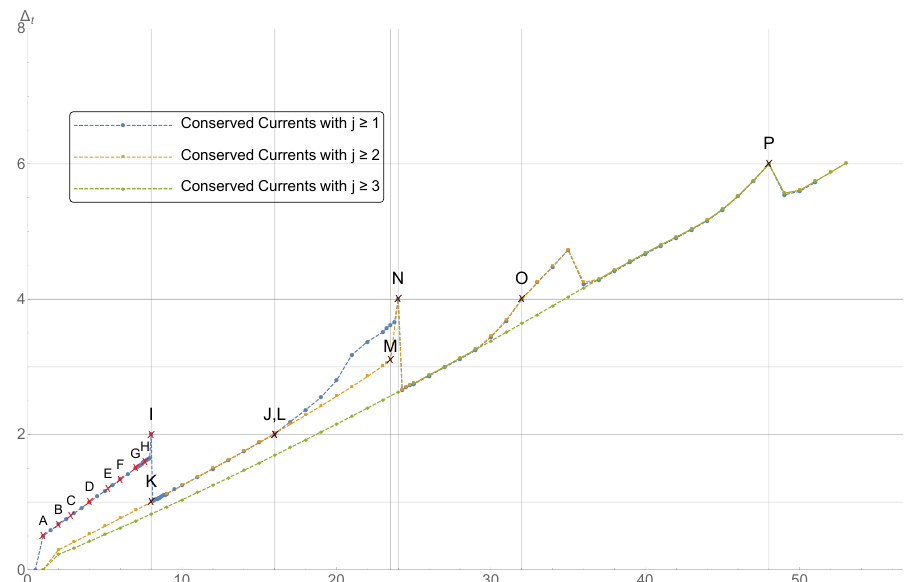
Figure 6. Numerical upper bounds on the twist gap in the range of 1 (cid:20) c (cid:20) 55 with the conserved currents of j (cid:21) 1, j (cid:21) 2 and j (cid:21) 3 included. Each x -mark on the boundary refers to a certain RCFT in given in tables 3,